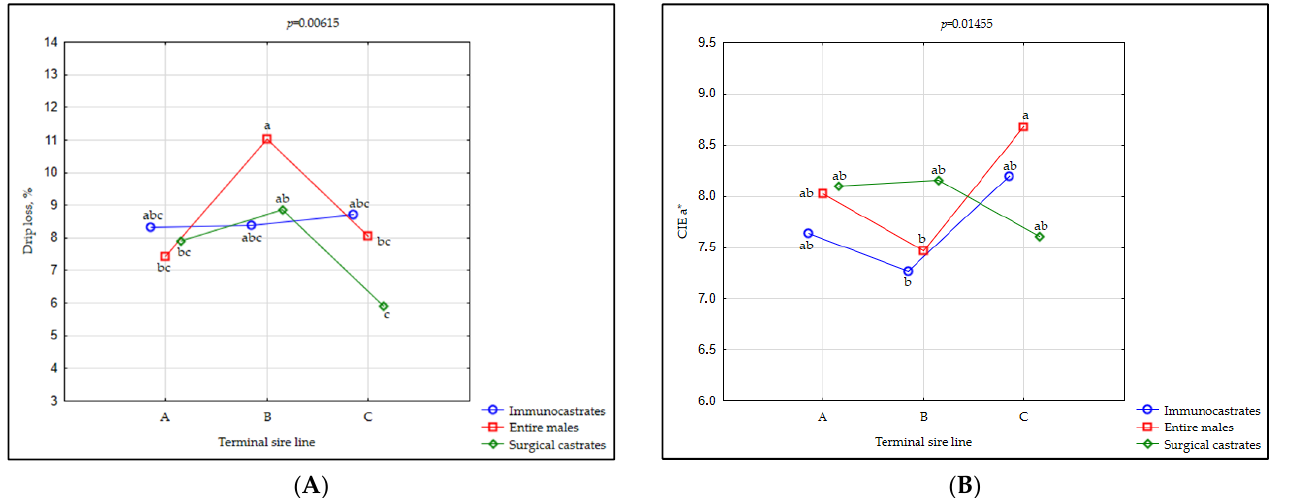
Figure 3. The interaction plot between terminal sire line (A, B, C) and male category (IC = immunocastrates; EM = entire males; SC = surgical castrates) for drip loss ( A ) and CIE a* values ( B ). TSL A = Pietrain × Large White, TSL B = pure Pietrain, TSL C= Pietrain × Duroc × Large White. Significant differences ( p < 0.05) between groups are denoted by different lowercase letters (a, b, c).